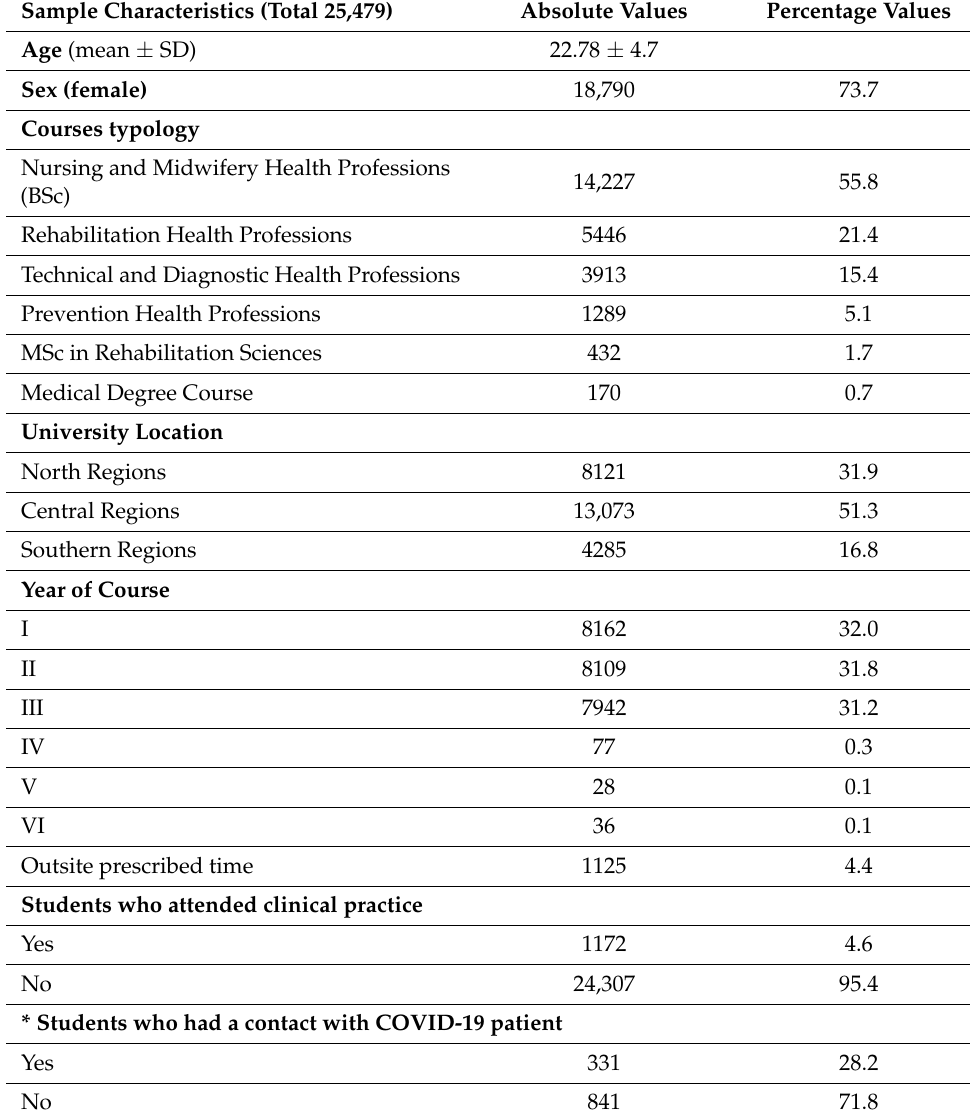
Table 1. Sample characteristics (total